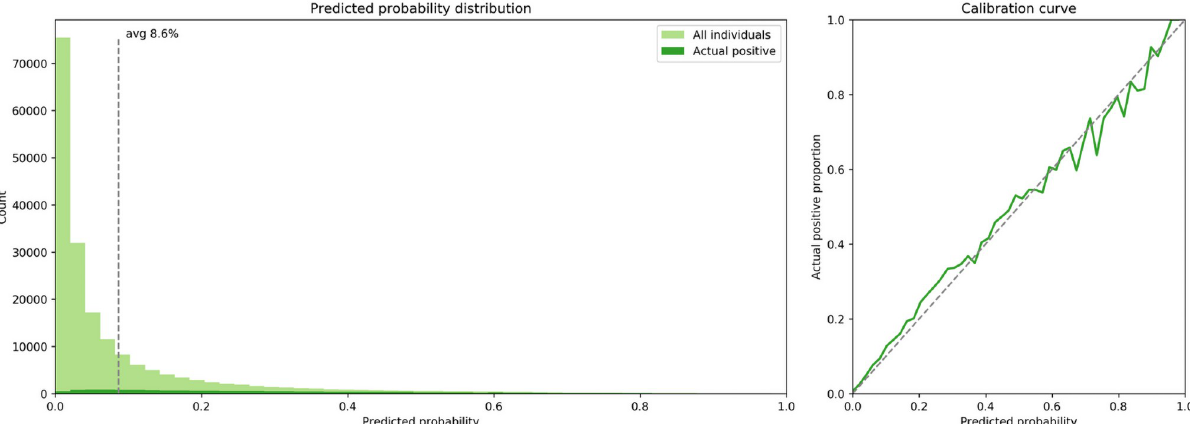
Fig 3. The Extreme gradient boosted tree model calibration for predicting 30-day mortality. The left pane l shows that the extreme gradient boosted (XGB) tree model produces a wide range of risk estimates for the test data set individuals, from 0.0 to 1.0. The right pane l is a calibration curve and shows that each risk score bin accurately represents the true average mortality rate of those individuals in that bin. In other words, the right panel shows that the predicted mortality curve (green line) follows the actual mortality curve (dashed line) closely.